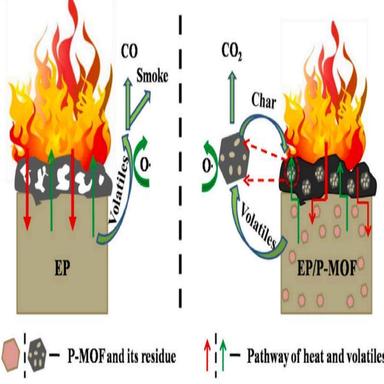
The schematic demonstration of phosphorus-MOF fire retardancy.